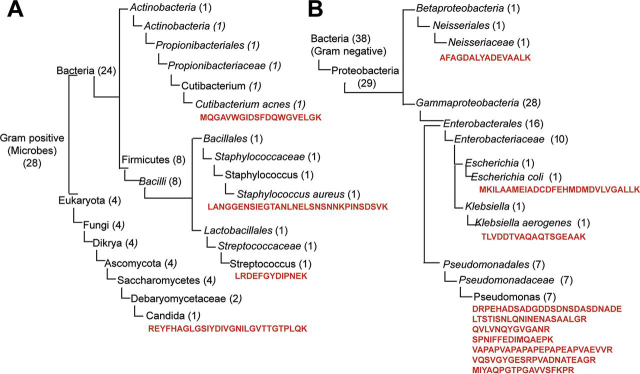
Taxonomic characterization of VAP pathogens using metaproteome approach. Dendogram of Gram-positive VAP pathogen (A) and Gram-negative VAP pathogens (B). In parenthesis the number of peptides identified at each level. The peptide sequence specific to lowest common ancestor are represented in red.